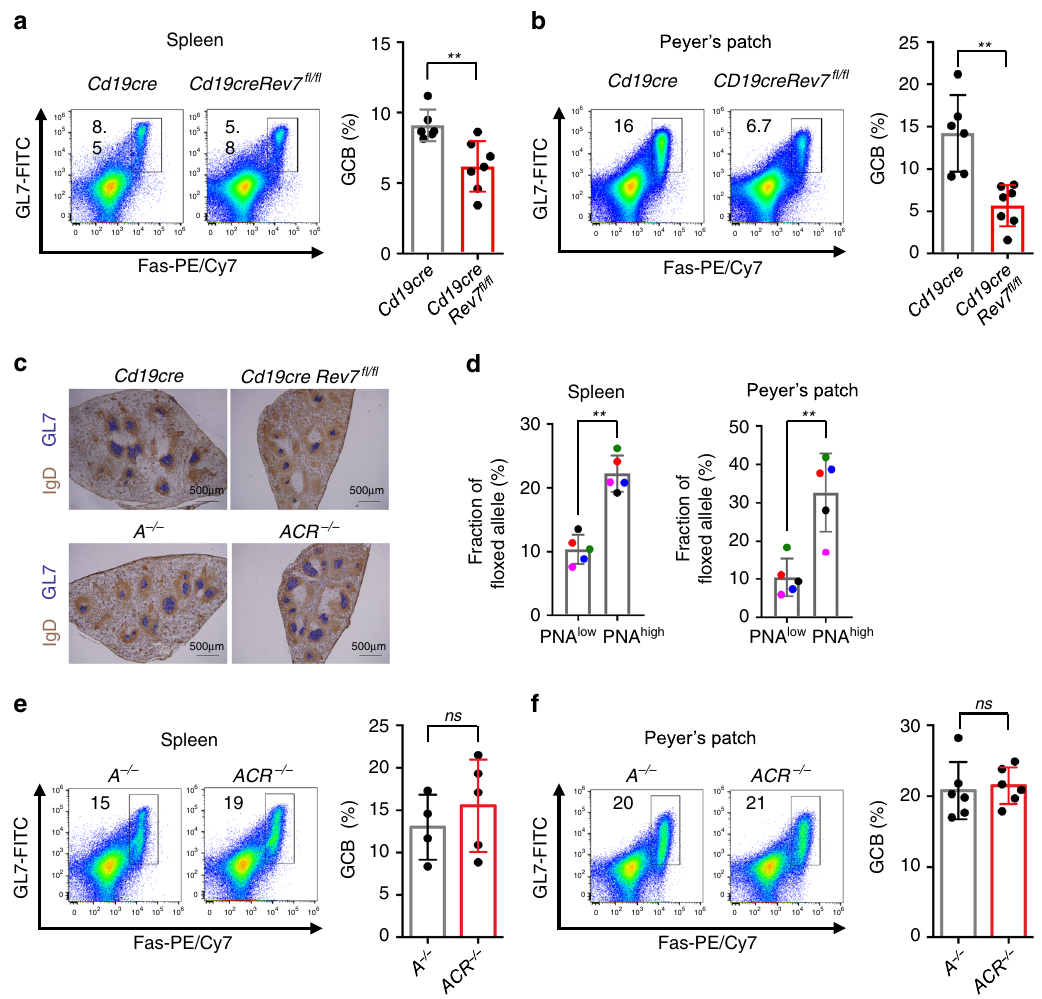
Fig. 5 AID-dependent depletion of REV7-de fi cient GC B cells. Fractions of GC B cells (GL7 + Fas + ) from spleens ( a ) and Peyer ’ s patches ( b ) are showed with exampled fl ow cytometry plots and summary bar graphs. Each dot indicate result from an individual mouse. Six Cd19cre and seven Cd19creRev7 fl / fl mice were assayed for a and b . c Immunohistochemistry of spleens of indicated genotype. Representative images from three sets of mice are showed. Scale bar, 500 μ m, is indicated as a black line on each picture. d Genotyping of indicated B (B220 + ) cell populations (PNA low : naive B cell, PNA high : GC B cell) in the spleen and Peyer ’ s patch. n = 5 mice. AID de fi ciency fully rescued the GC B-cell depletion in spleens ( e ) and Peyer ’ s patches ( f ) of Rev7-de fi cient mice. Four Cd19cre and fi ve Cd19creRev7 fl / fl mice were assayed for e . Six Cd19cre and Cd19creRev7 fl / fl mice were assayed for f . Data are represented as mean ± SD. Two-tailed unpaired t -test was performed for a , b , e , and f ; two-tailed paired t -test was performed for d . ** p < 0.01, ns: p > 0.05. P -values and sample sizes are provided in Supplementary Table 2. Source data are provided as a Source Data fi Fig. 13a), which was much more toxic to REV7-de fi cient cells (Supplementary Fig. 13b). Although UNG inhibitor UGI is